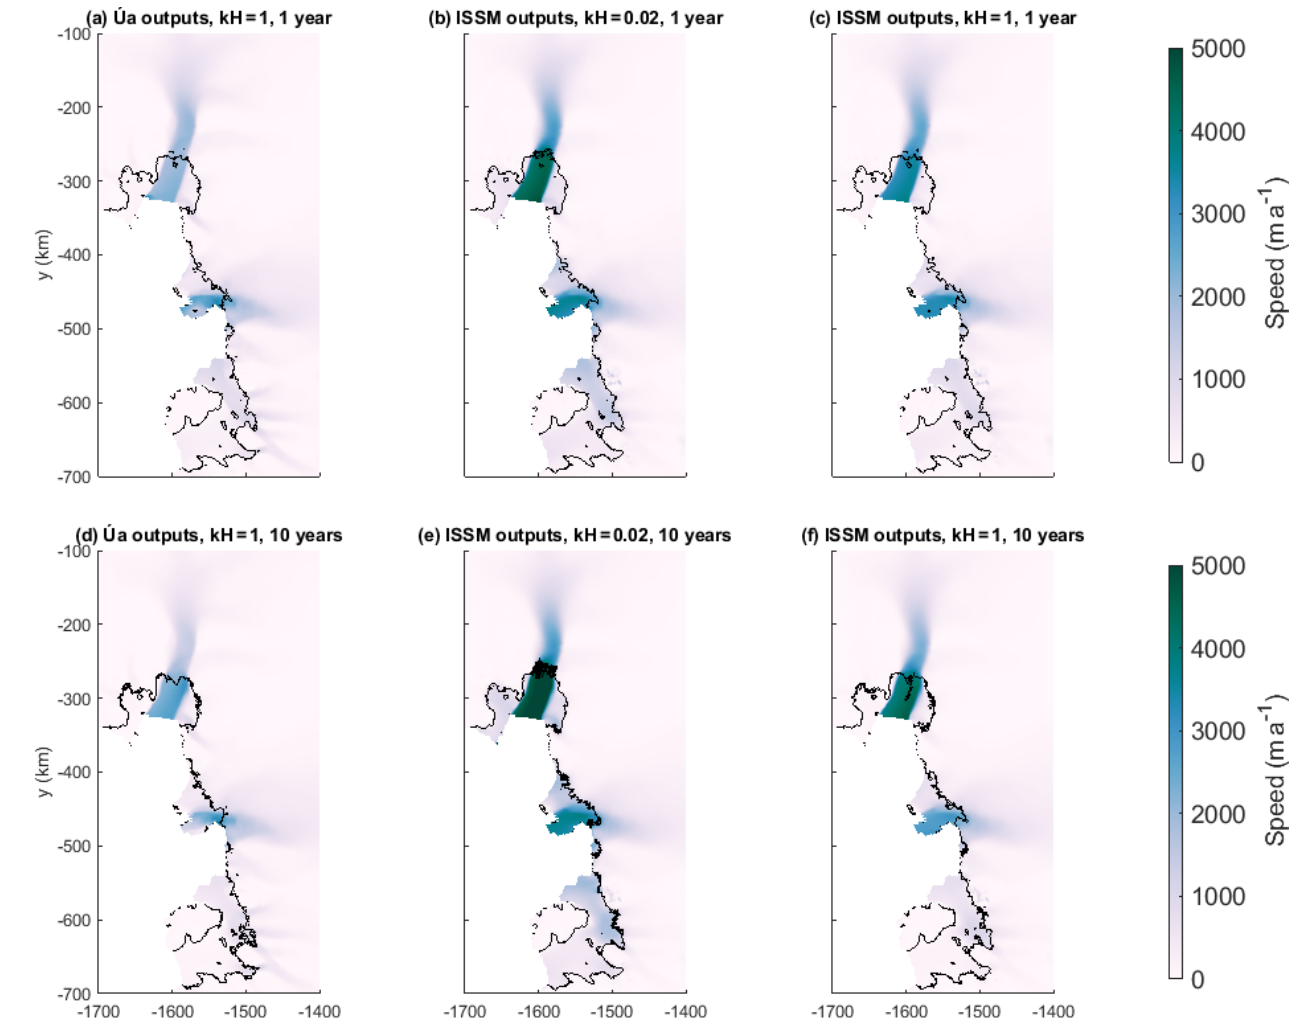
Figure C3. Speeds and grounding lines after 1 and 10 years of simulation in Úa using its own inversion outputs and those of ISSM with two different values of kH